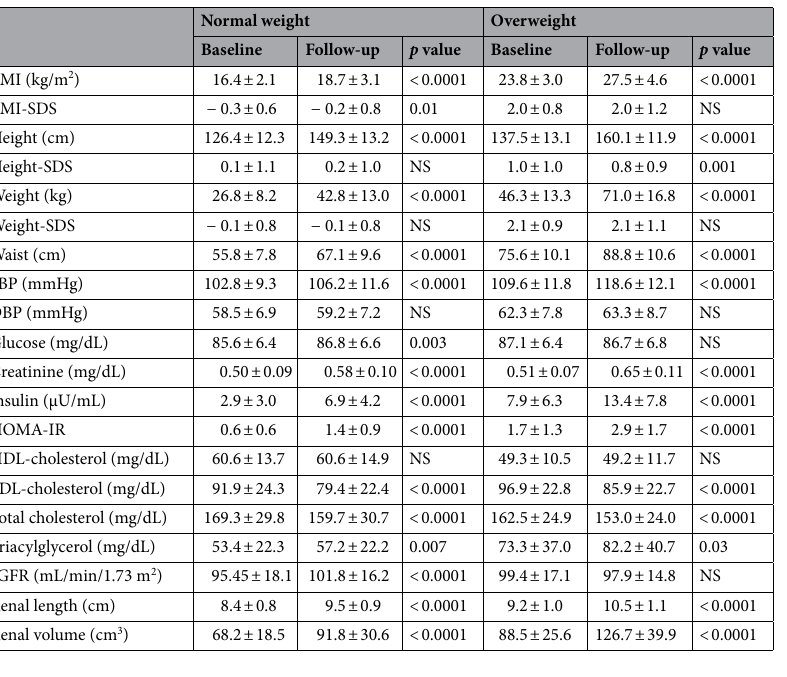
Table 1. Comparison between baseline and follow-up data in normal weight and overweight groups. BMI body mass index, SBP systolic blood pressure, DBP diastolic blood pressure, eGFR estimated